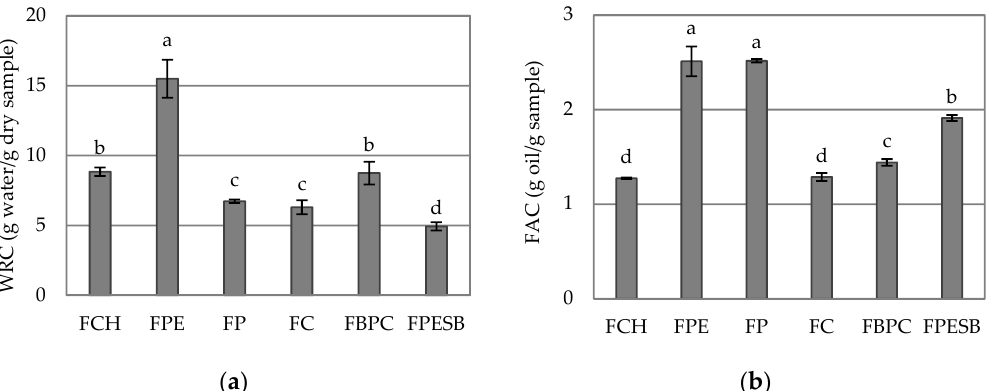
Figure 3. Mean values and standard deviations of ( a ) water retention capacity (WRC) and ( b ) fat absorption capacity (FAC) of DF samples. Letters indicate homogeneous groups established by the ANOVA ( p < 0.05).